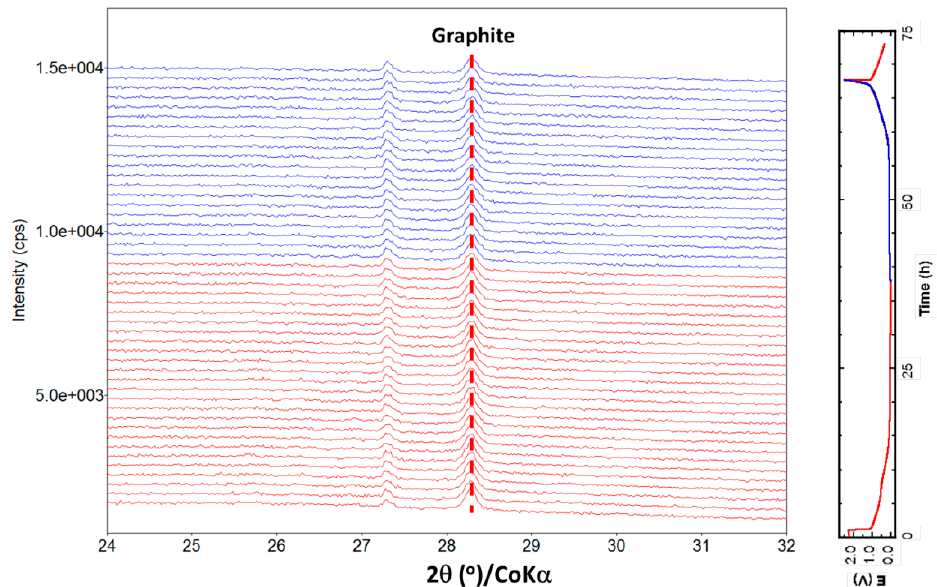
Figure 6. Structure evolution during electrochemical cycle. In situ XRD patterns collected during the first discharge/charge of the HC-1400 electrode cycled between 0–2.5 V at 0.05 C rate with 1M NaTFSI/EC:DEC electrolyte.